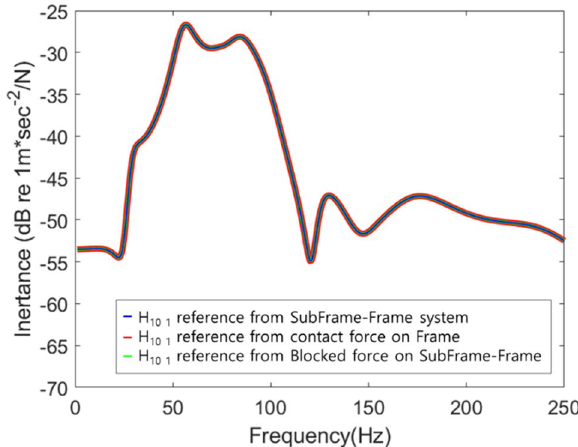
Figure 10. Response of the simplified structure.